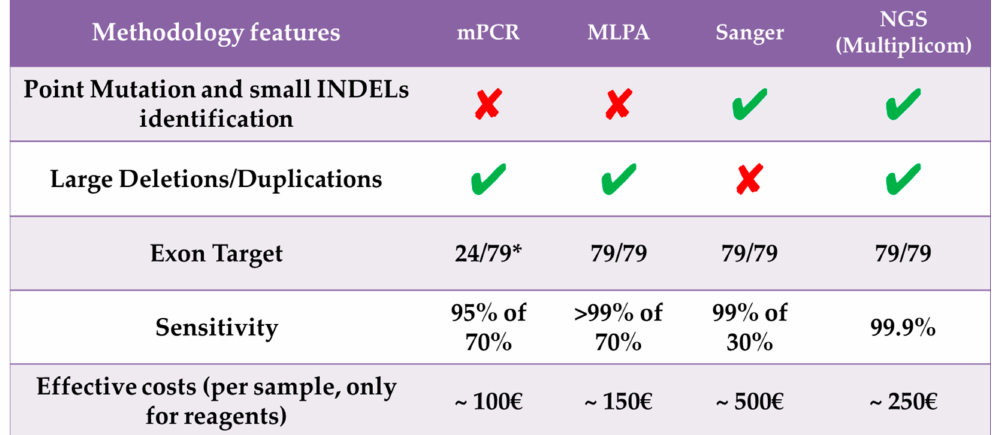
Figure 4. Comparison of the performances of traditional analytical approaches with respect to the NGS strategy used in the present study. *mPCR amplifies only mutational hotspots in 24 out of 79 exons of DMD gene. DMD, Duchenne muscular dystrophy; INDELs, small insertions and deletions; MLPA, multiplex ligation-dependent probe amplification; mPCR, multiplex polymerase chain reaction; NGS, next generation sequencing.